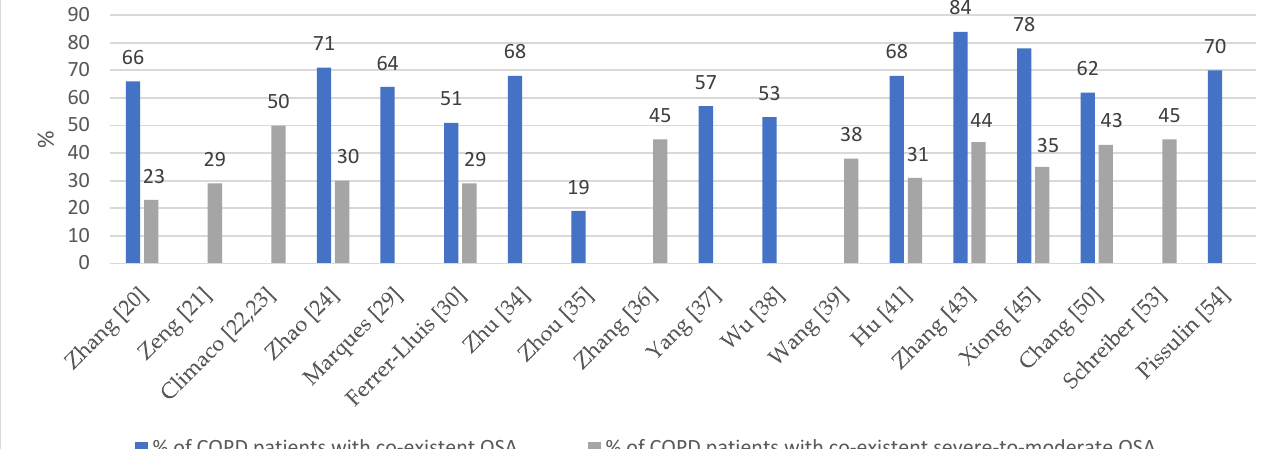
% of COPD patients with co‐existent severe‐to‐moderate OSA Figure 3. The prevalence of OSA in COPD patients in the included studies Figure 3. The prevalence of OSA in COPD patients in the included studies [20–24,29,30,34–39,41,43, [20 ‐ 24,29,30,34 ‐ 39,41,43,45,50,53,54].